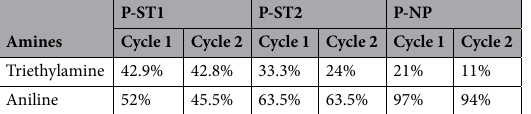
Table 2. Percentage quenching efficiency and reusability of perylene silica nanoparticles in sensing amines in